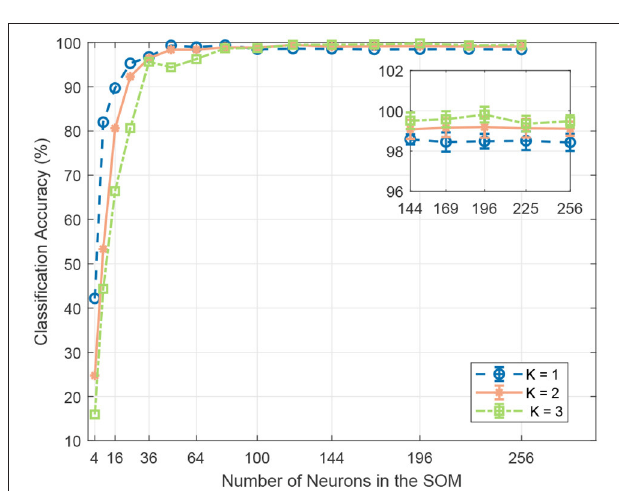
FIGURE 6 | The effect of the SOM neural map size and number of BMUs per frame on classification accuracy. A larger neural map can capture more feature variations and generate more discriminative spiking patterns for different sound events. However, the accuracy plateaus once the number of neurons exceeds 121. As shown in the inset, for neural maps of size above 121, increasing the number K of BMUs for each frame enhances system robustness with redundancy and improves classification